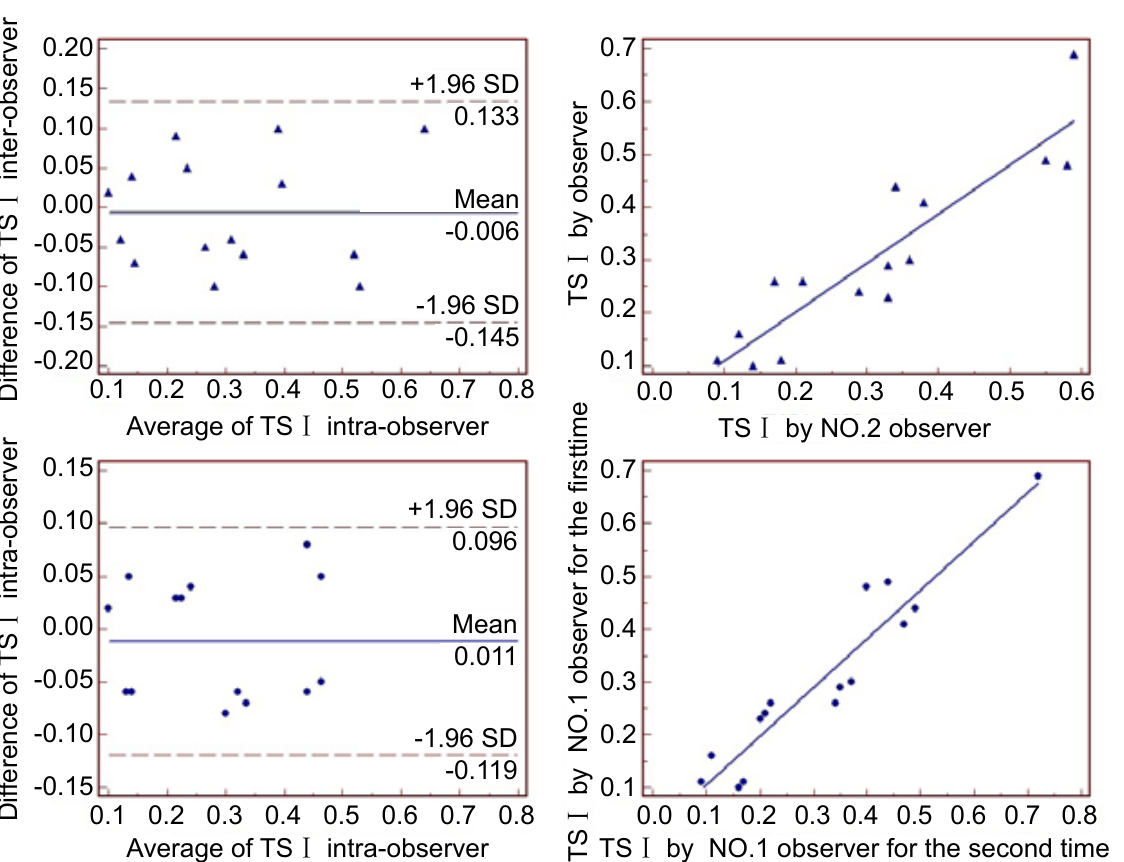
Figure 1 Repeatability evaluation of echo-derived indices was adopted linear correlation analysis and Bland-Altman Plots at rest and peak exercise. Correlation and agreement of TSI were measured by inter-observers and